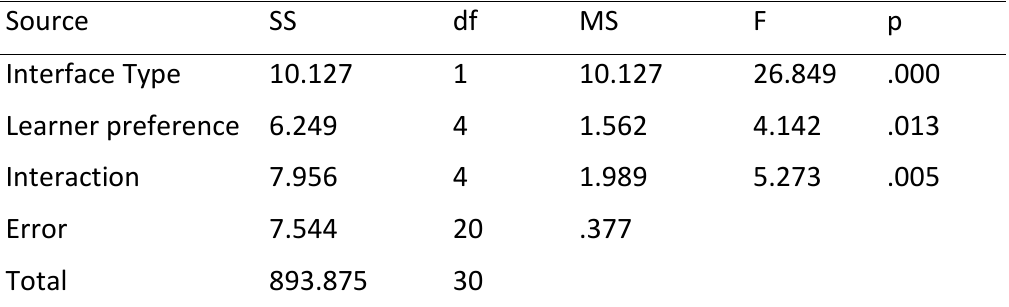
Table 5. Two-Way ANOVA Summary Table for the Effect of Learner Preference and Interface